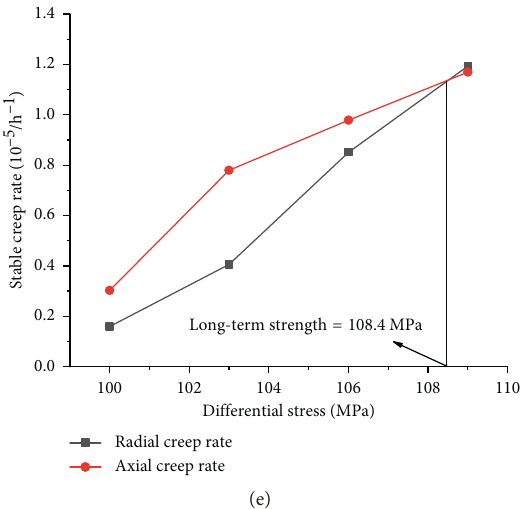
Figure 13: Stable creep rate-differential stress curve. (a) T0 specimen. (b) T10 specimen. (c) T20 specimen. (d) T40 specimen. (e) T60 specimen.